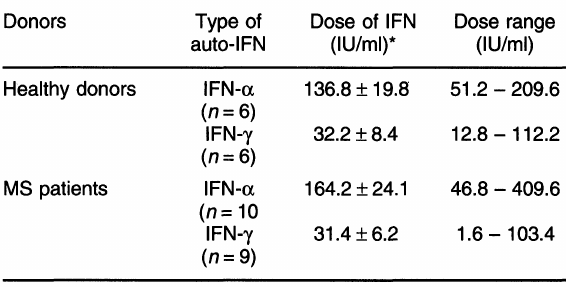
Table 1. Doses of auto-IFNs used in the study of IFN action on PBL NK activity Donors